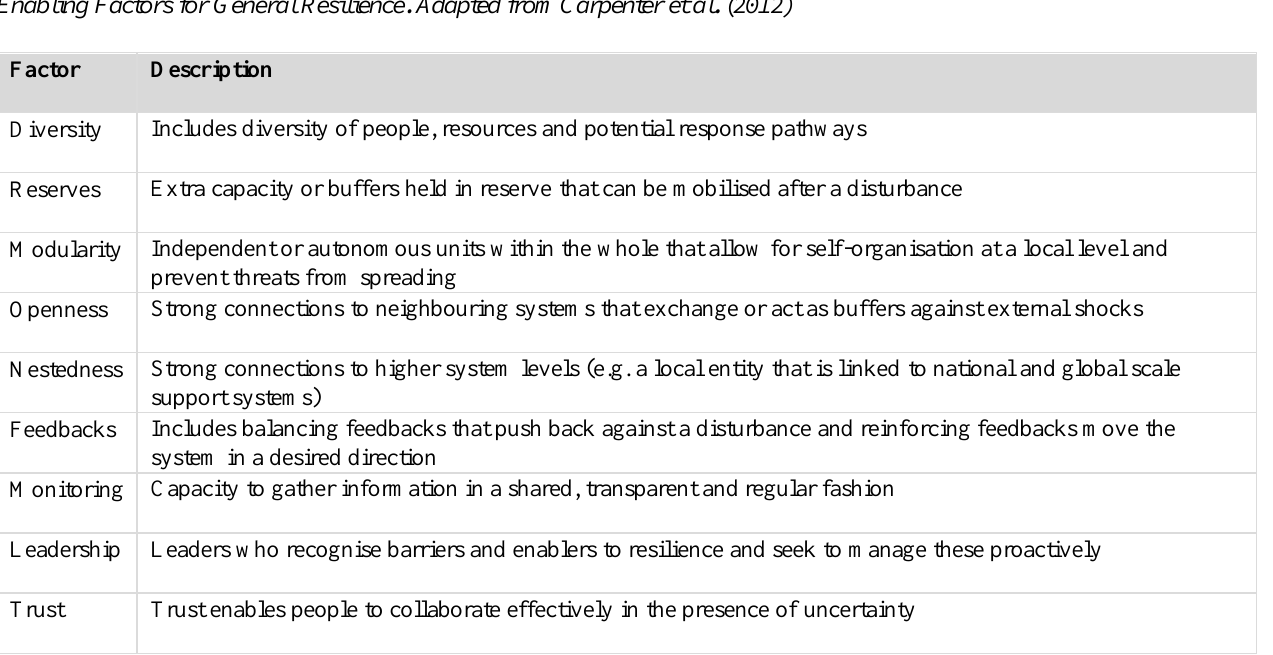
Enabling Factors for General Resilience. Adapted from Carpenter et al.